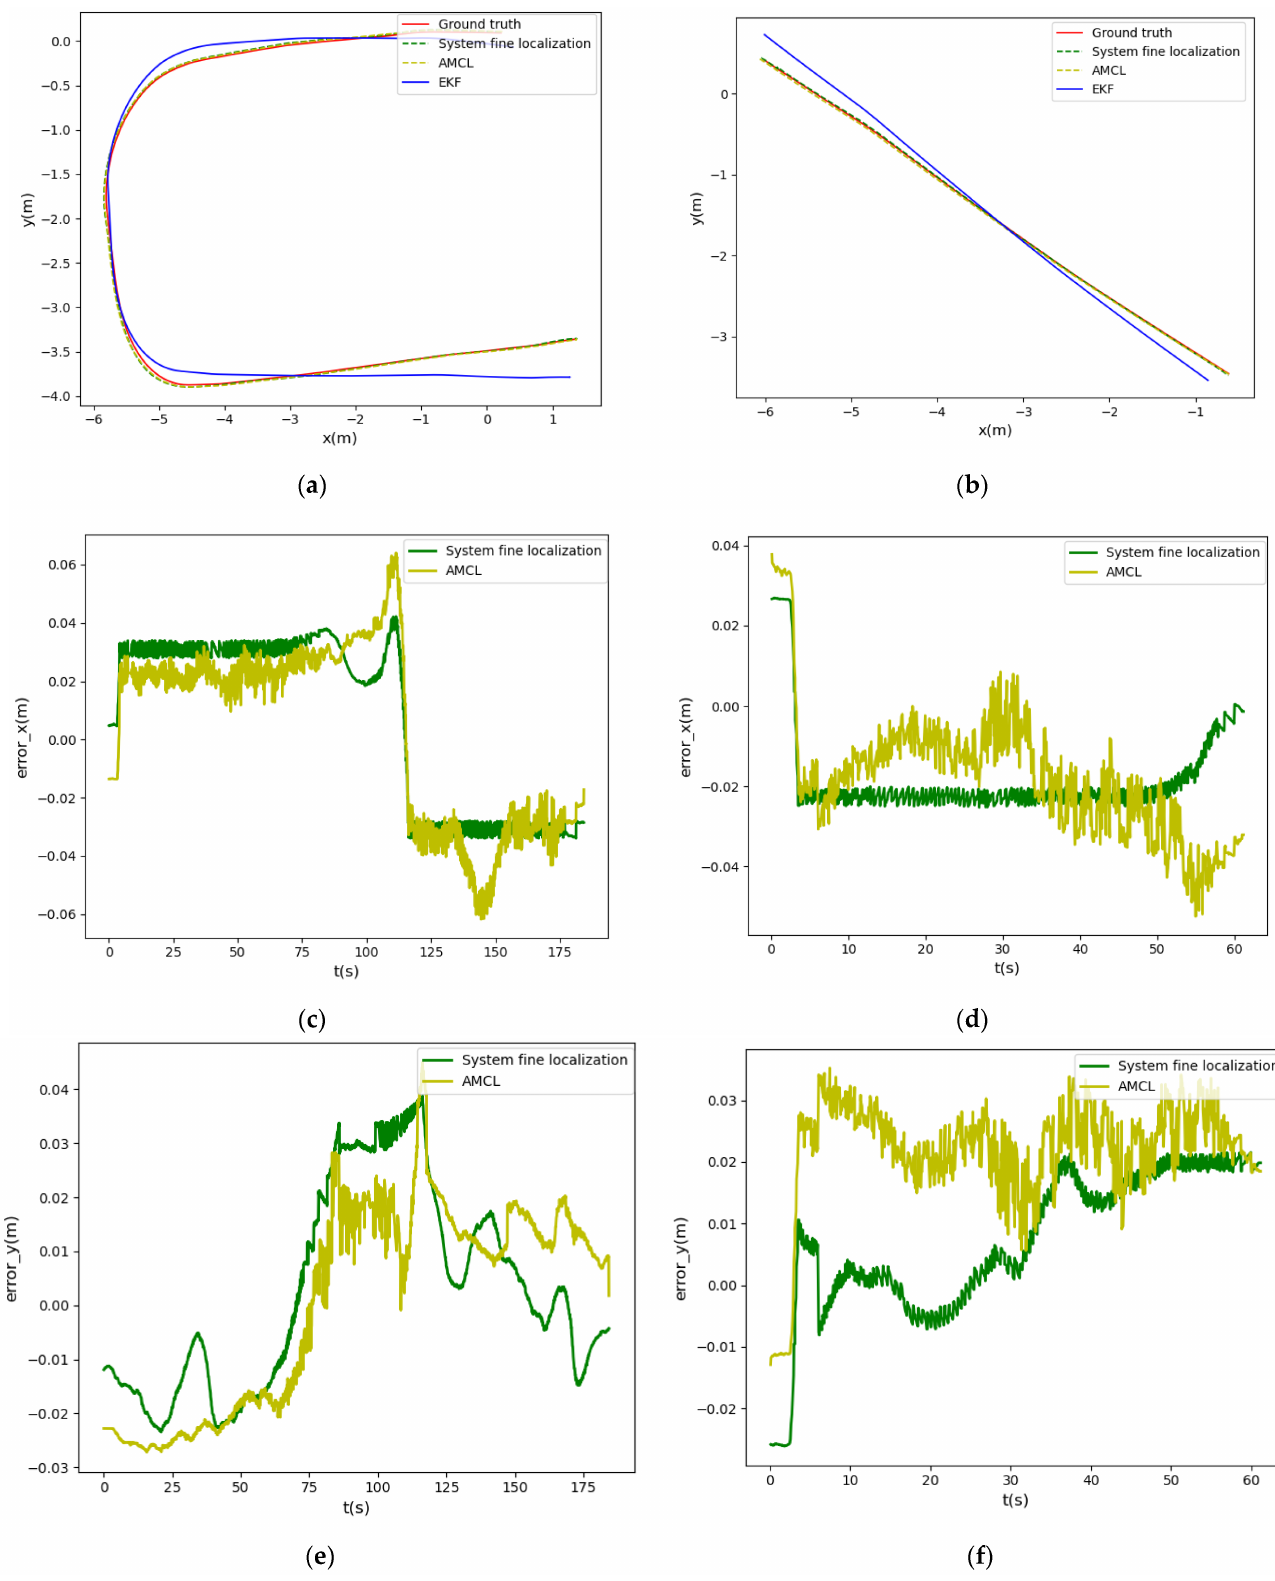
Figure 21. Comparison of the pose estimation and their errors of the two test trajectories. ( a , b ) Compari- son of predicted trajectories;( c , d ) Position deviation in x direction; ( e , f )Position deviation in y